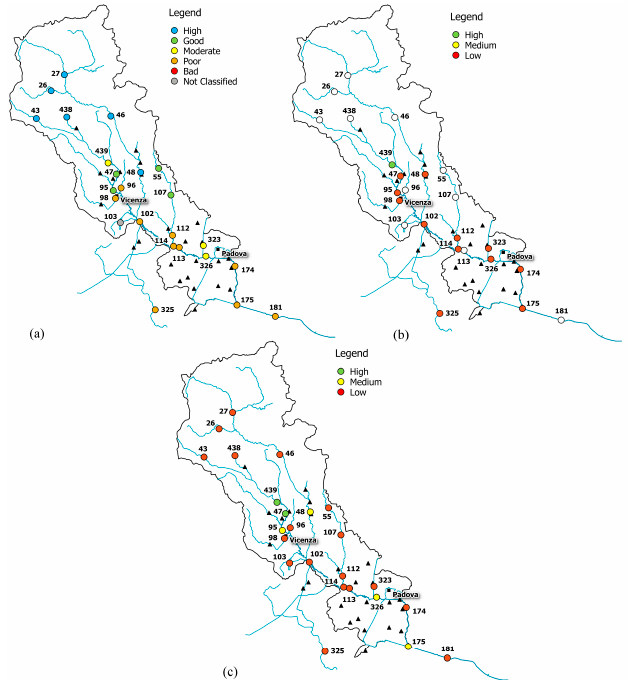
Figure 7. ( a ) Water-quality classification according to the macro-descriptor LIMeco; ( b ) level of functional integrity for the Non-Treated Loads index; ( c ) level of functional integrity for the Total Pollutant Reduction index (year 2012).